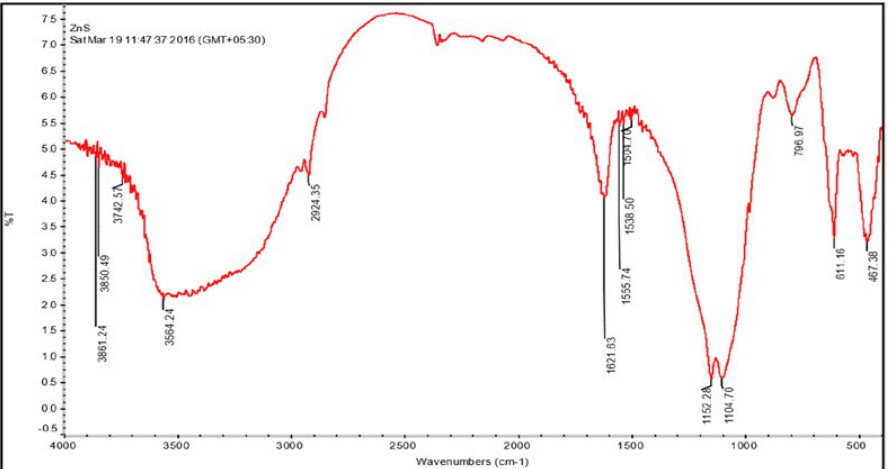
Fig. 7. FTIR Image of ZnO -SiO